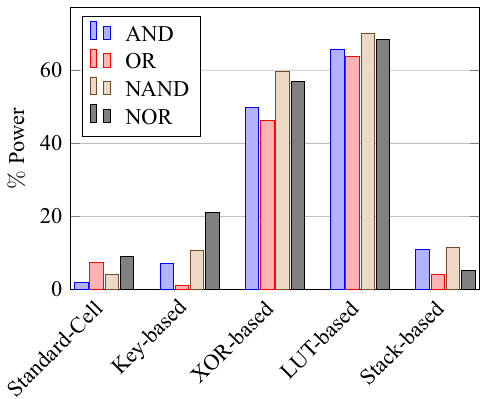
Figure 40. % Change in power compared to proposed design.